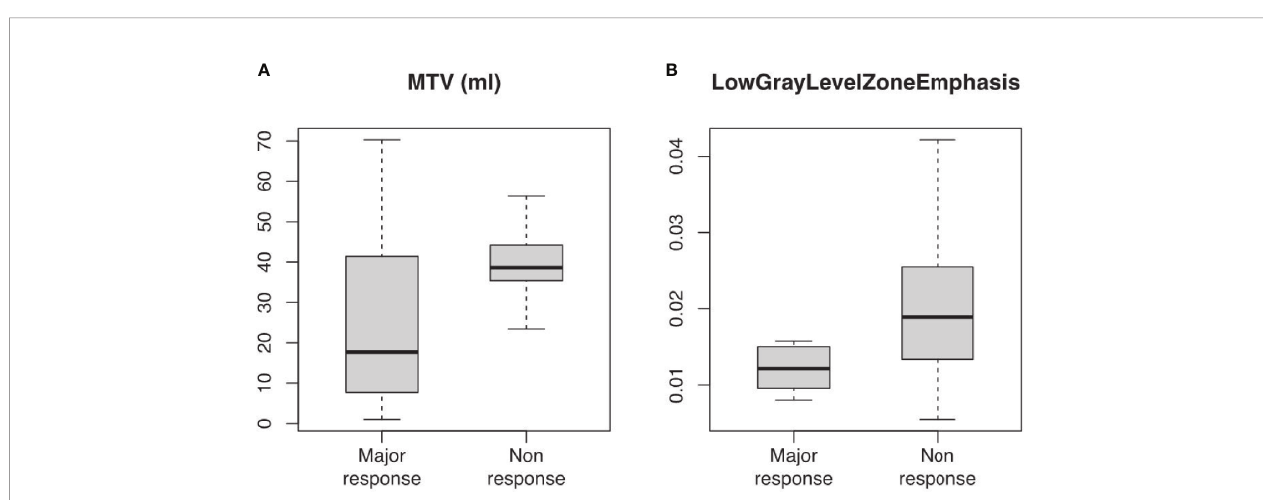
FIGURE 3 | Sagittal fused 18 F-FDG PET/CT images obtained at baseline (PET 1 ) and after induction chemotherapy (PET 2 ). A signi fi cant response to induction chemotherapy (reduction in metabolic parameters) of the esophageal lesion can be observed. The patient was classi fi ed as TRG1 at fi nal pathological examination. PET 1 parameters: SUV max 26.9, SUV mean 12.7, MTV 43.7 ml, TLG 553.9; PET 2 parameters: SUV max 6.7, SUV mean 3.2, MTV 15.9 ml, TLG